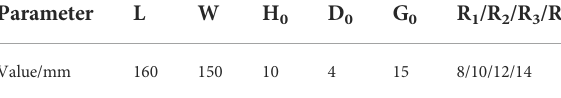
TABLE 1 Structural parameters of cooling